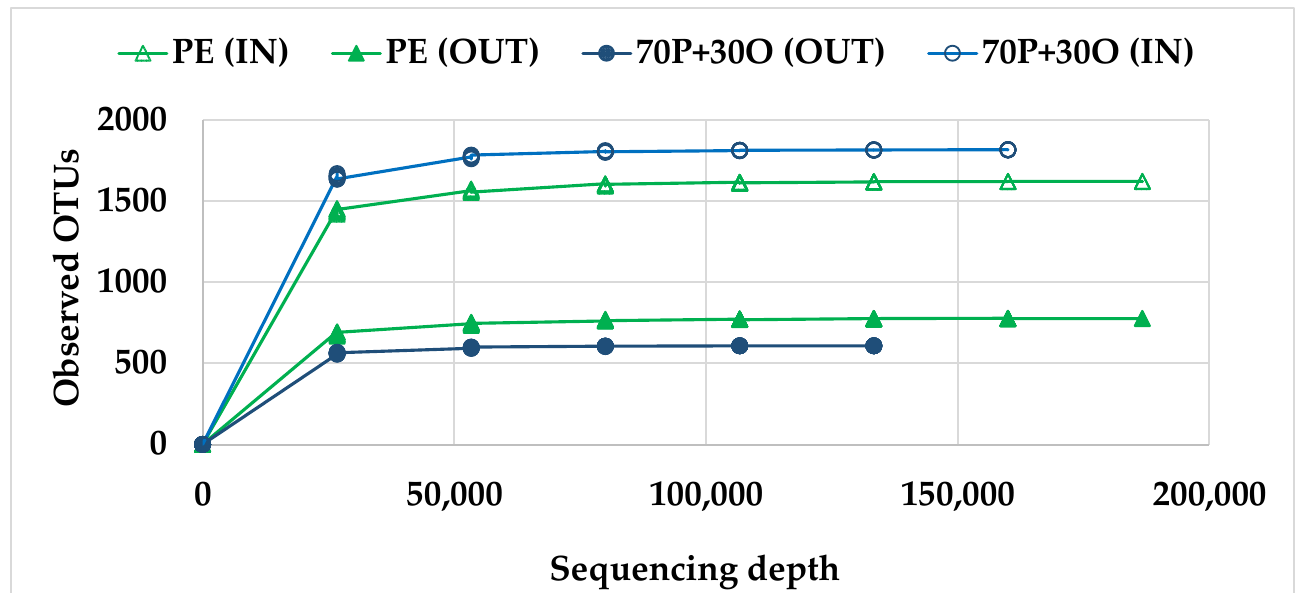
Figure 2. Alpha rarefaction curves for the occurrence with which OTUs were detected at each sample. Relative abundance of bacterial and archaea groups was determined in terms of the percentage of total number of sequences in each sample.